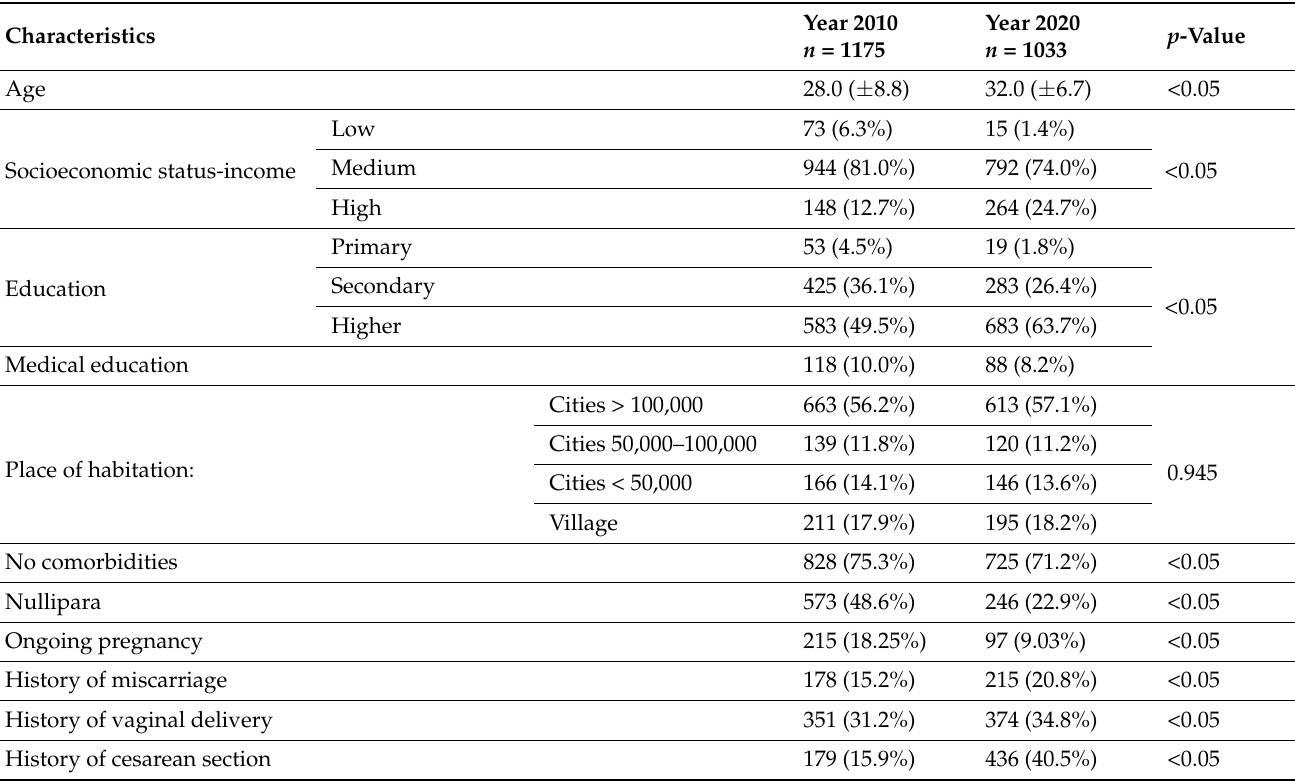
Table 1. Basic characteristics of